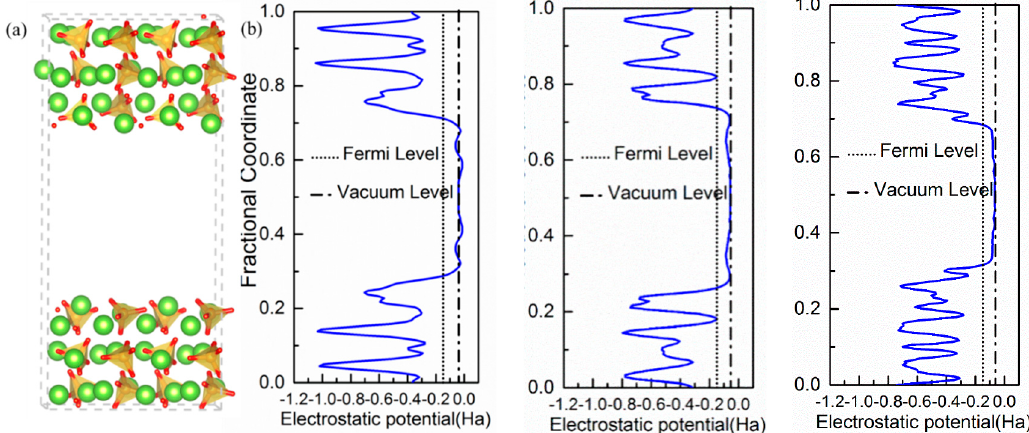
Figure 1. ( a ) Atomic representation of the β -C 2 S (100) surface model visualized with VESTA [35]. Red, green, and orange spheres represent oxygen, calcium, and silicate atoms, respectively. The SiO 4 − 4 groups are further represented as orange tetrahedral. ( b ) Electrostatic potentials along with the vertical vectors of the slab for the (100), (101), and (010) cleavage directions. The solid line represents the vacuum level.